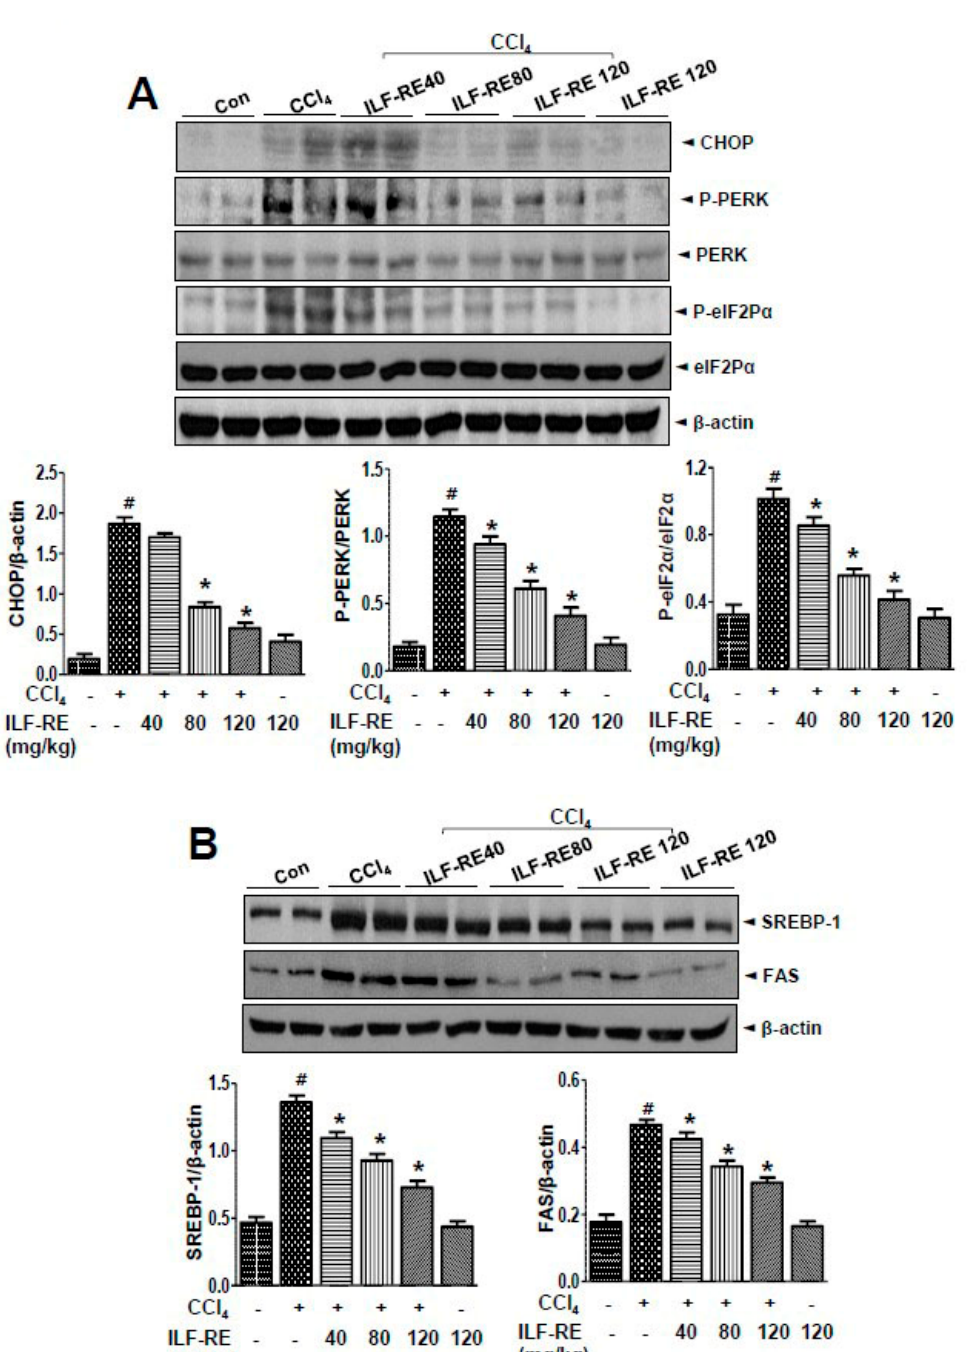
Figure 9. ILF-RE regulated ER stress and lipogenic effect in CCl 4 -induced hepatotoxicity. Rats were intraperitoneally administered CCl 4 (0.2 mL/100 g, BW) twice a day for 4 weeks. ILF-RE (40, 80, or 120 mg/kg) was co-administered with CCl 4 or 120 mg/kg ILF-RE on its own for 4 weeks, followed by harvesting of the liver. ( A ) Immunoblotting was performed using anti-SREBP-1, anti-FAS, and anti- β -actin antibodies. Protein expression levels were determined relative to the loading control. ( B ) Immunoblotting was performed using anti-CHOP, anti-p-PERK, anti-PERK, anti-p-eIF2 α , anti-eIF2 α , and anti- β -actin antibodies. The experiments were performed in triplicate using tissues from at least three rats in each group. # p < 0.05 vs. Con group; * p < 0.05 vs. CCl 4 group ( n = 10 rats per group). BW, body weight; Con, control; CCl 4 , carbon tetrachloride; ILF-RE, the combination R. verniciflua with E. ulmoides.